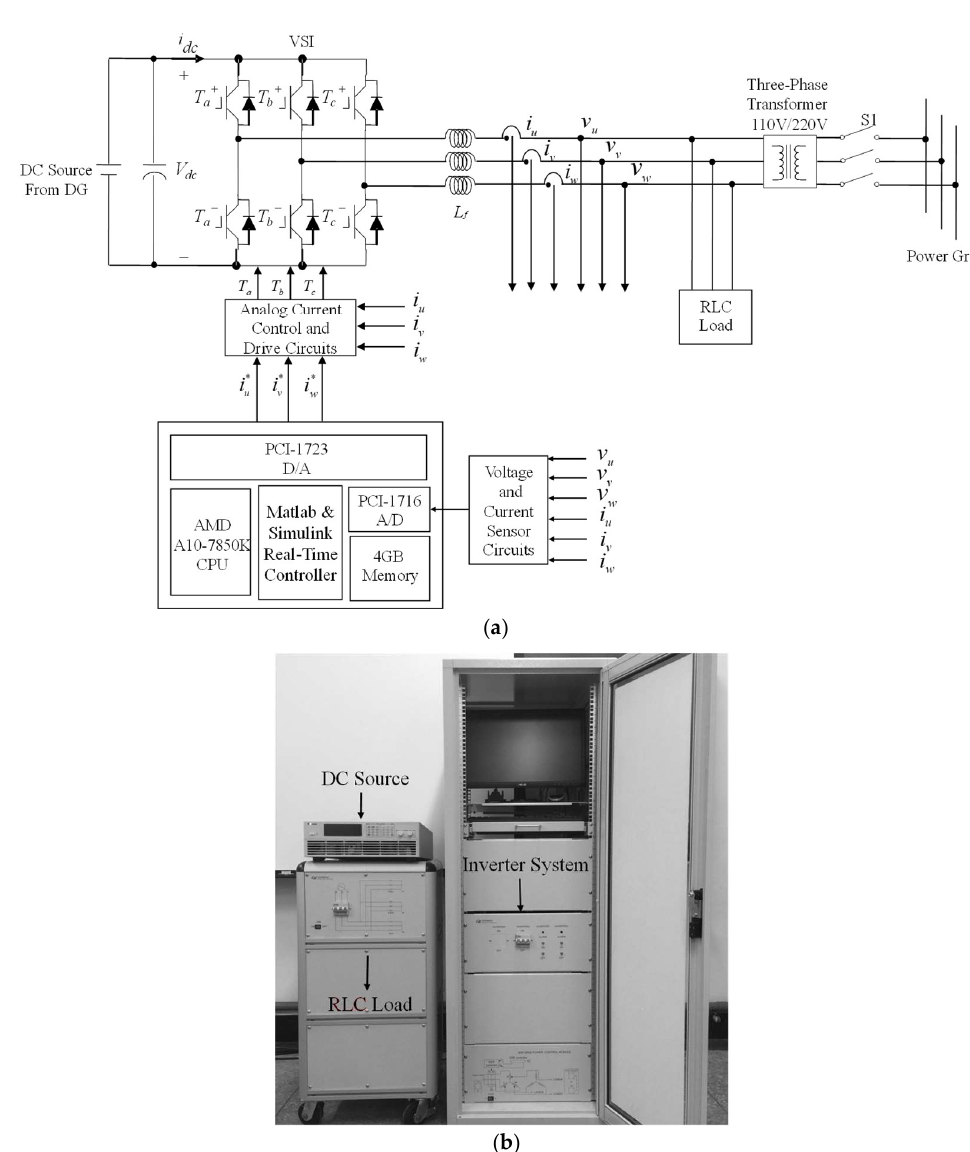
Figure 5. DG system for tracking control and islanding detection: ( a ) Block diagram of the PC-based control computer; ( b ) Photos of the PC-based laboratory setup.